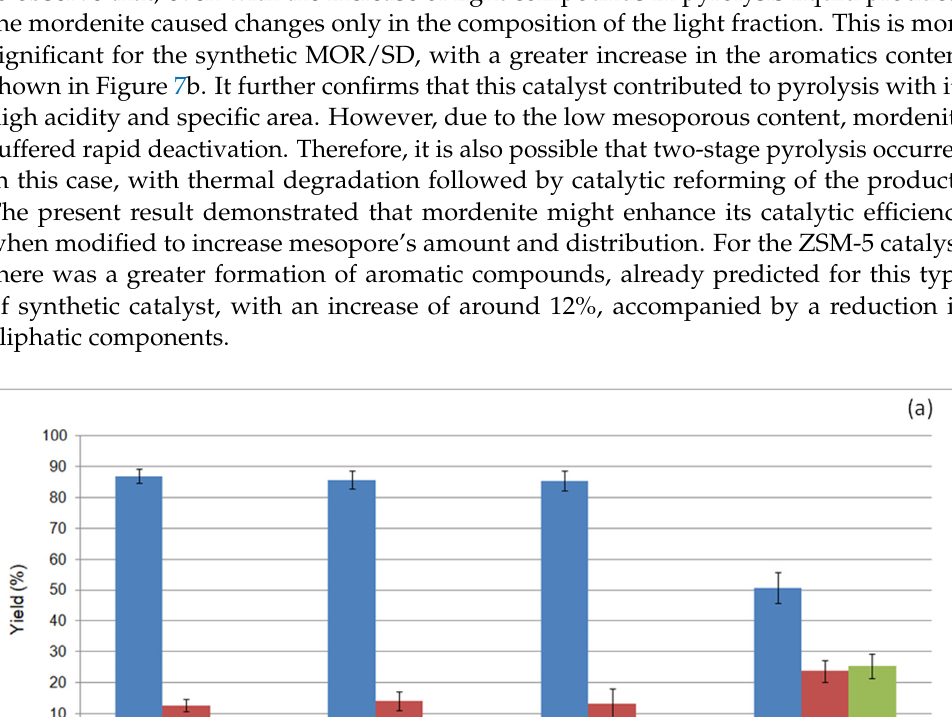
Figure 6. ( a ) Distribution of the pyrolysis products (gaseous, liquid, and solid fractions) of the PMix with different catalysts and the chromatograms of complete pyrolysis oil; ( b ) non-catalytic, ( c ) MOR/02, ( d ) MOR/SD, ( e ) ZSM-5/02. By evaluating the composition of the pyrolytic oil of the PMix in Figure 7, it is possible to observe that, even with the increase of light compounds in pyrolysis liquid products, the mordenite caused changes only in the composition of the light fraction. This is more significant for the synthetic MOR/SD, with a greater increase in the aromatics content shown in Figure 7b. It further confirms that this catalyst contributed to pyrolysis with its high acidity and specific area. However, due to the low mesoporous content, mordenite suffered rapid deactivation. Therefore, it is also possible that two-stage pyrolysis occurred in this case, with thermal degradation followed by catalytic reforming of the products. The present result demonstrated that mordenite might enhance its catalytic efficiency when modified to increase mesopore’s amount and distribution. For the ZSM-5 catalyst, there was a greater formation of aromatic compounds, already predicted for this type of synthetic catalyst, with an increase of around 12%, accompanied by a reduction in aliphatic components.